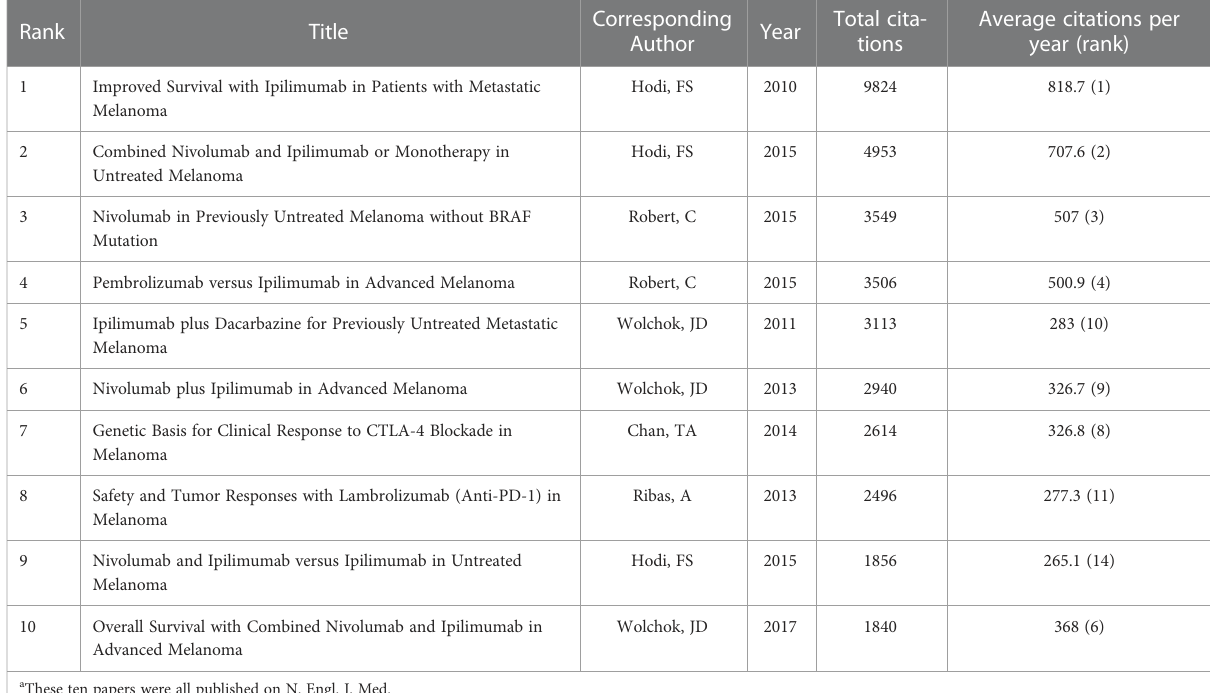
Corresponding Total cita- Average citations per Year Author tions year